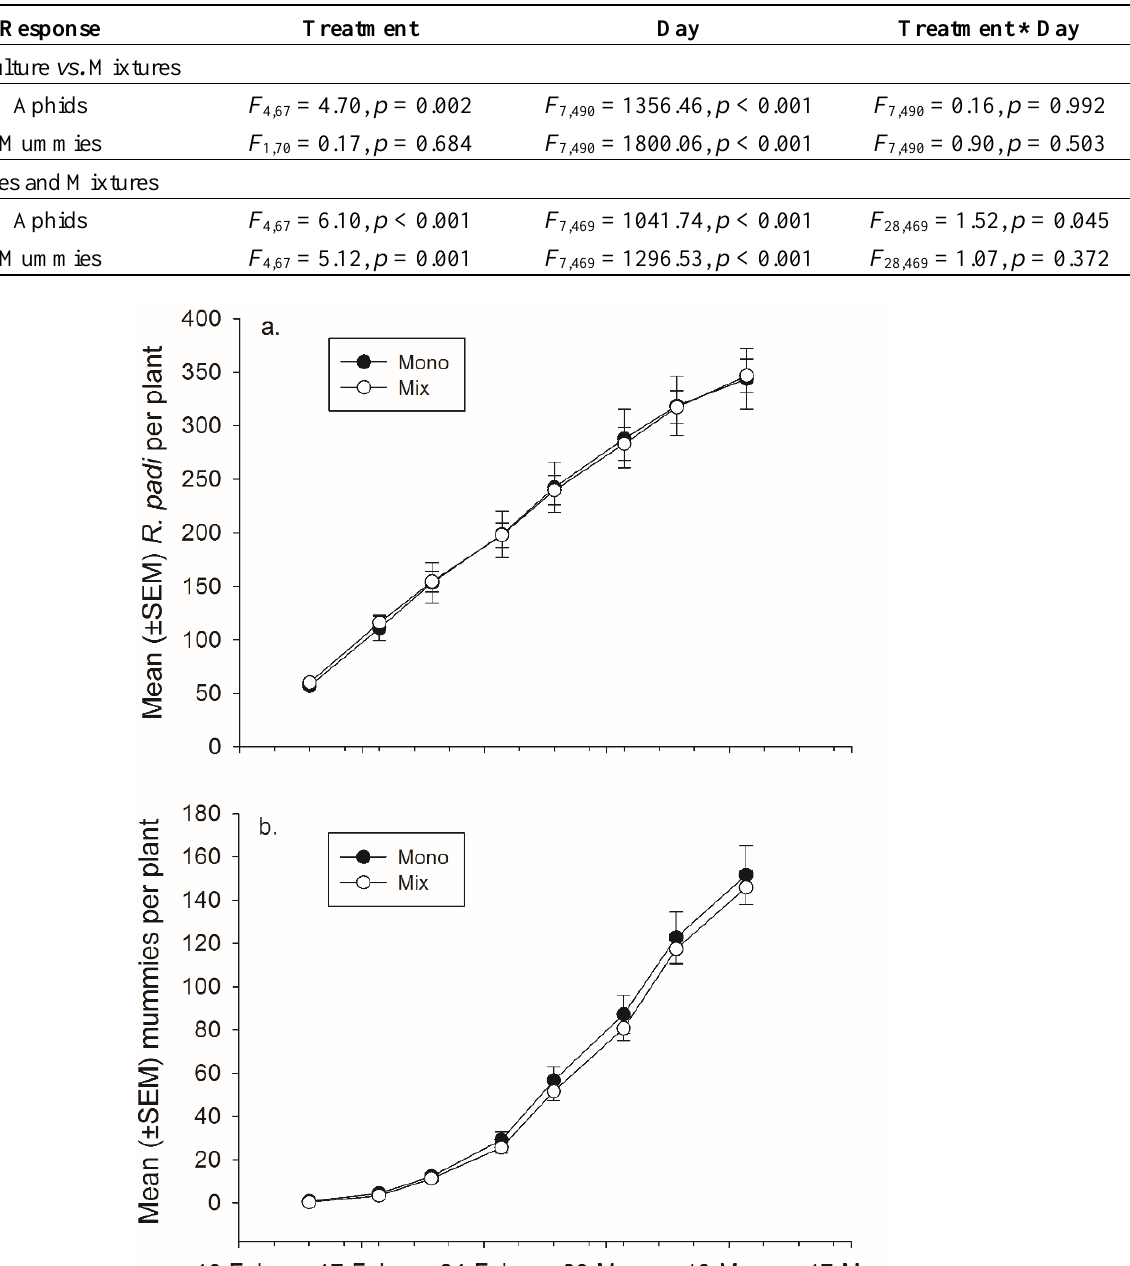
Table 4. Results of repeated measures ANOVAs testing the effect of diversity (monocultures vs. mixtures) and the effect of species and mixtures on aphid and mummy abundance per banker plant.